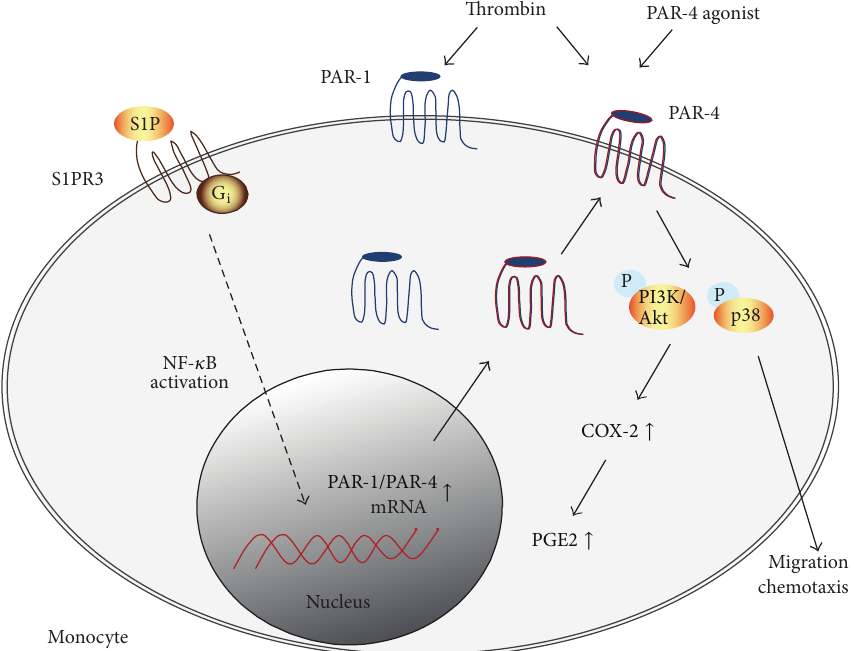
Figure 5: Interactions of S1PRs and PARs in monocyte function. In human monocytes, S1P significantly enhances expression of the thrombin receptors PAR-1 and PAR-4 at the mRNA and protein level. Elevation of PAR-1/PAR-4 abundance appears to be mediated via activation of S1PR3 and results in increased migration of the monocyte toward thrombin. These responses are associated with PI3K/Akt-mediated expression of COX-2. At sites of vascular injury, increased levels of S1P, for example, released from aggregating platelets, may enhance the inflammatory response of local monocytes, thereby modulating tissue-targeted events such as thrombosis and vessel injury.